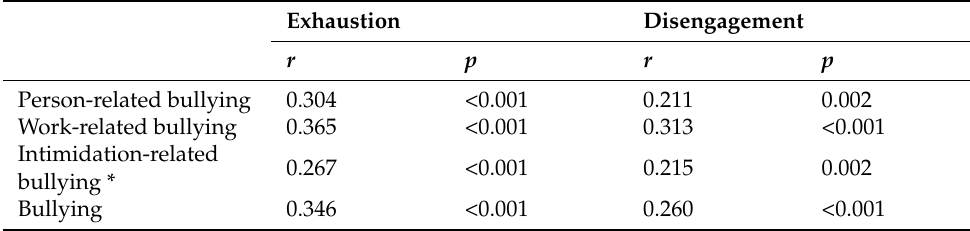
Table 5. Correlations between bullying and burnout.